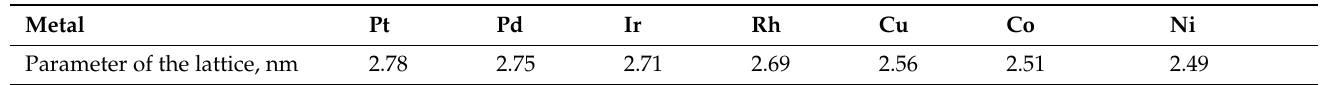
Table 2. Hydrogen release rates during dehydrogenation of some